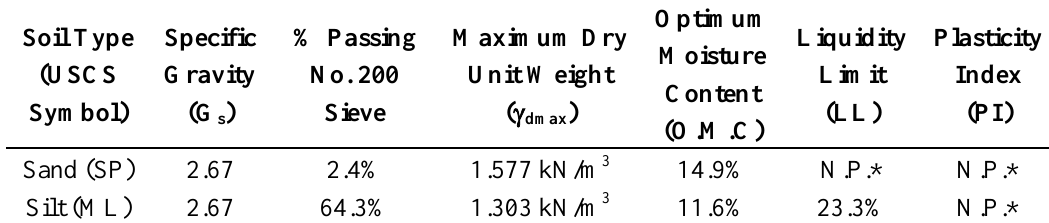
Table 1. Physical properties of the soils used in this study. USCS, Unified Soil Classification